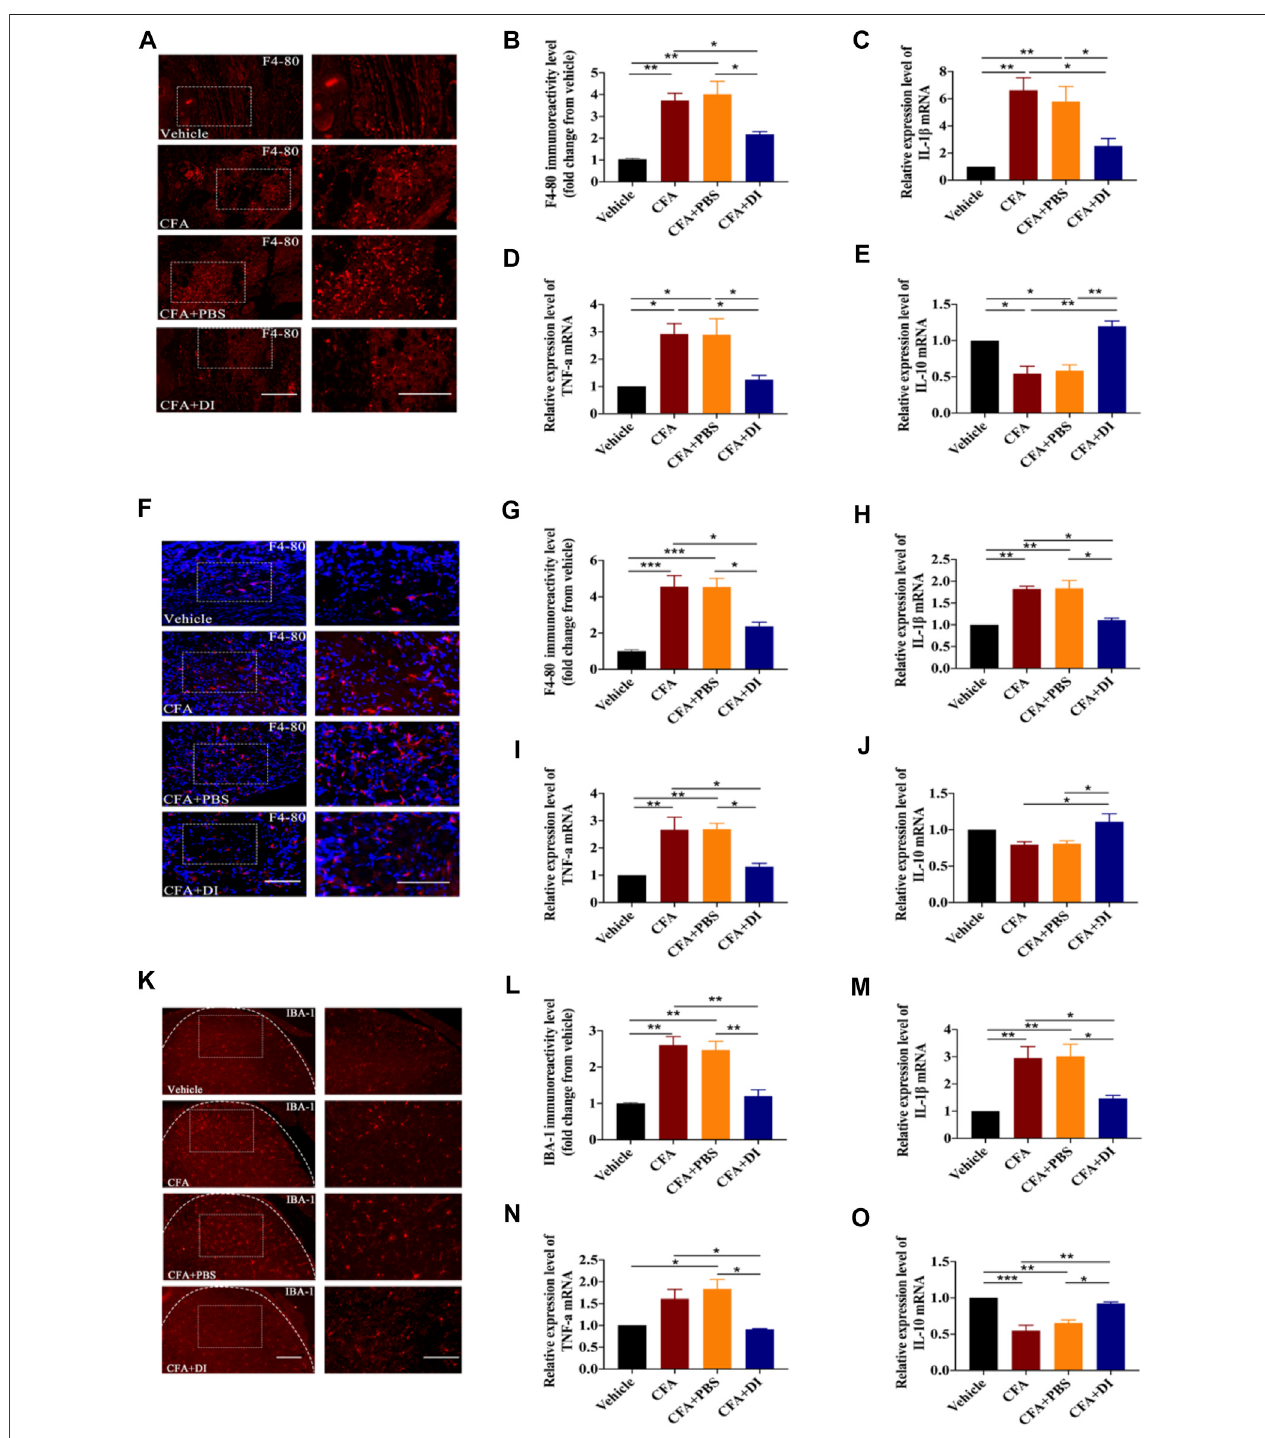
FIGURE 4 | Effect of DI on macrophage and microglia activation. (A) Immunostaining of F4-80 (red) showing macrophages activation in paw tissue. The scale bar represents100 μ m(left)and50 μ m(right). (B) Representativeimmuno fl uorescencestaininglevelforF4-80,foldchangeversusthevehiclegroup.F group (3,8)=16.65for (B) . Real-time PCRwere used todetect pro-in fl ammatoryfactors IL-1 β , F group (3, 12) = 11.87 for (C) , TNF- α , F group (3, 8) = 8.567 for (D) and anti-in fl ammatoryfactor IL- 10, F group (3, 8) = 18.75 for (E) . (F) Immunostaining of F4-80 (red) and DAPI (blue) showing macrophages activation in DRG. The scale bar represents 100 μ m (left) and 50 μ m (right). (G) Representative immuno fl uorescence staining level for F4-80, fold change versus the vehicle group. F group (3, 12) = 18.83 for (G) .Real-time PCR were used to detect pro-in fl ammatory factors IL-1 β , F group (3, 12) = 20.84 for (H) , TNF- α , F group (3, 12) = 11.49 for (I) and anti-in fl ammatory factor IL-10, F group (3, 12) =